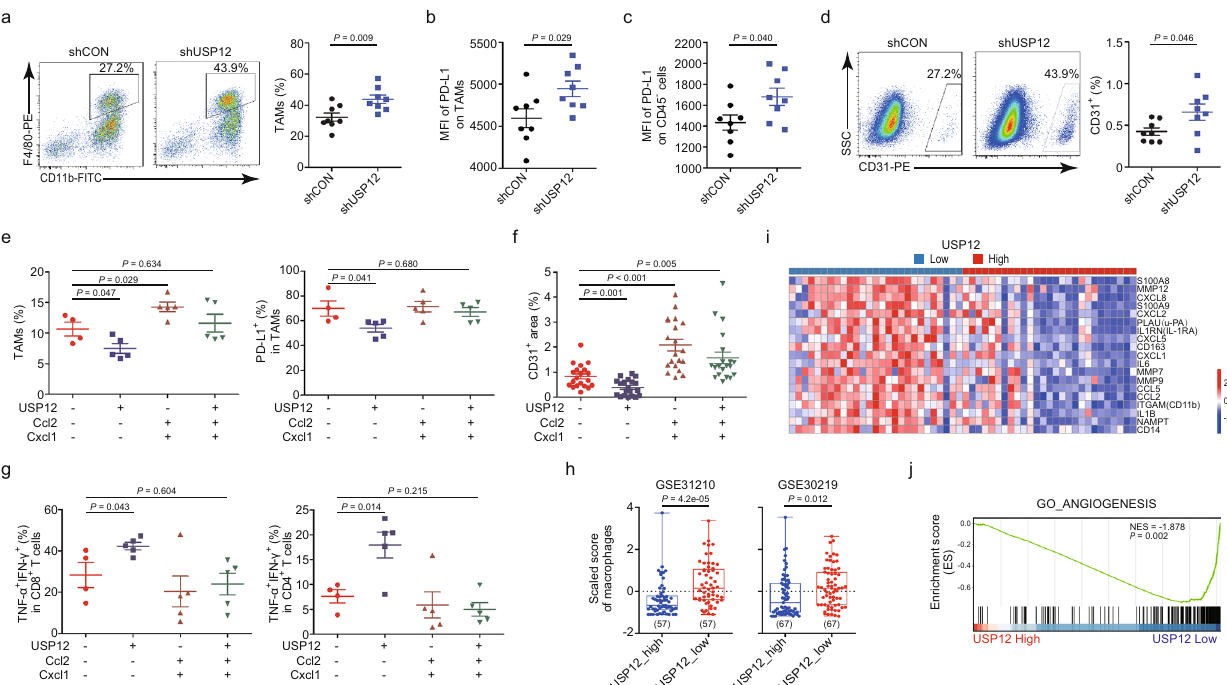
Fig. 5 USP12 modulates immune cell composition and activation in tumour microenvironment. a – d Flow cytometric analysis of the proportion of TAMs ( a ), PD-L1 expression on TAMs ( b ), PD-L1 expression on CD45 − cells ( c ), and the proportion of CD31 + CD45 − cells ( d ) in LLC tumours (mean ± SEM, n = 8 per group). 2-tailed unpaired t -test. e Flow cytometric analysis of the proportion of TAMs and PD-L1 expression on TAMs in indicated 889-S1 tumours (mean ± SEM, n = 4 − 5 per group). One-way ANOVA followed by Tukey ’ s HSD test. f Quanti fi cation analysis of CD31 immunostaining of indicated 889-S1 tumours (mean ± SEM, n = 20 fi elds of view from >3 mice). Kruskal-Wallis test. g The proportion of TNF- α + IFN- γ + cells gated on CD8 and CD4 T cells